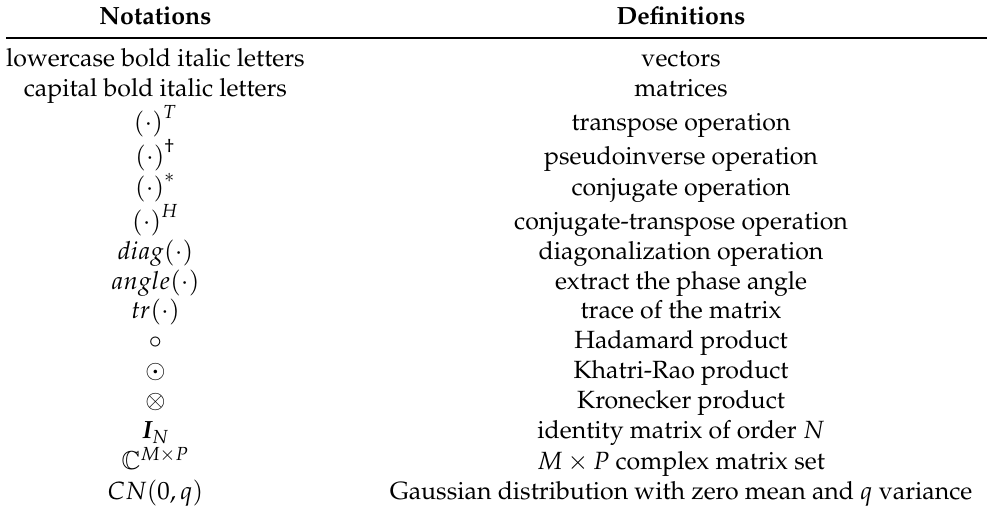
Table 1. Related